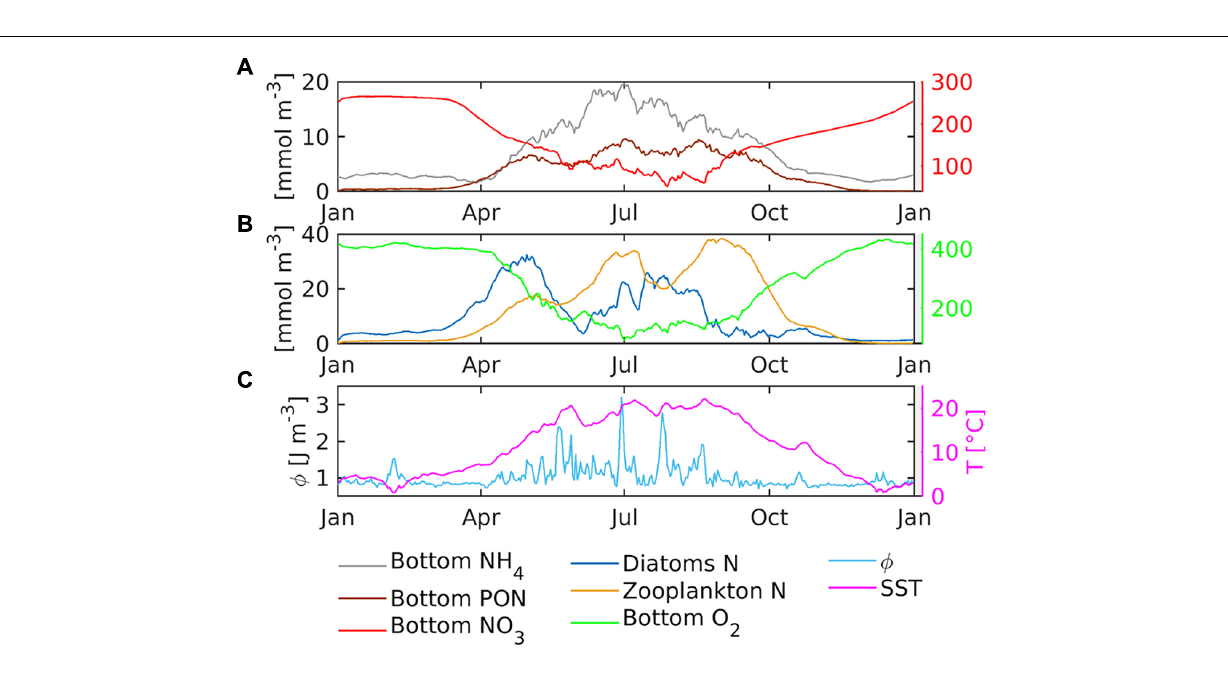
Frontiers in Marine Science |